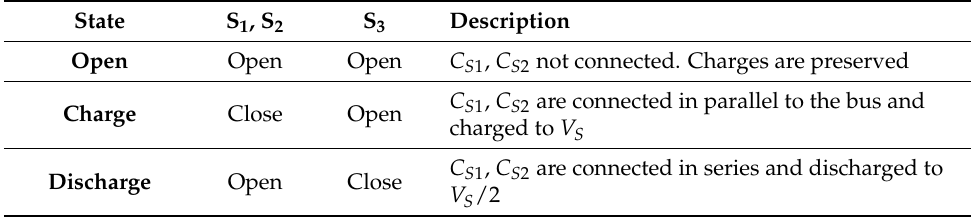
Table 2. States of 3-switches transmitter topology.